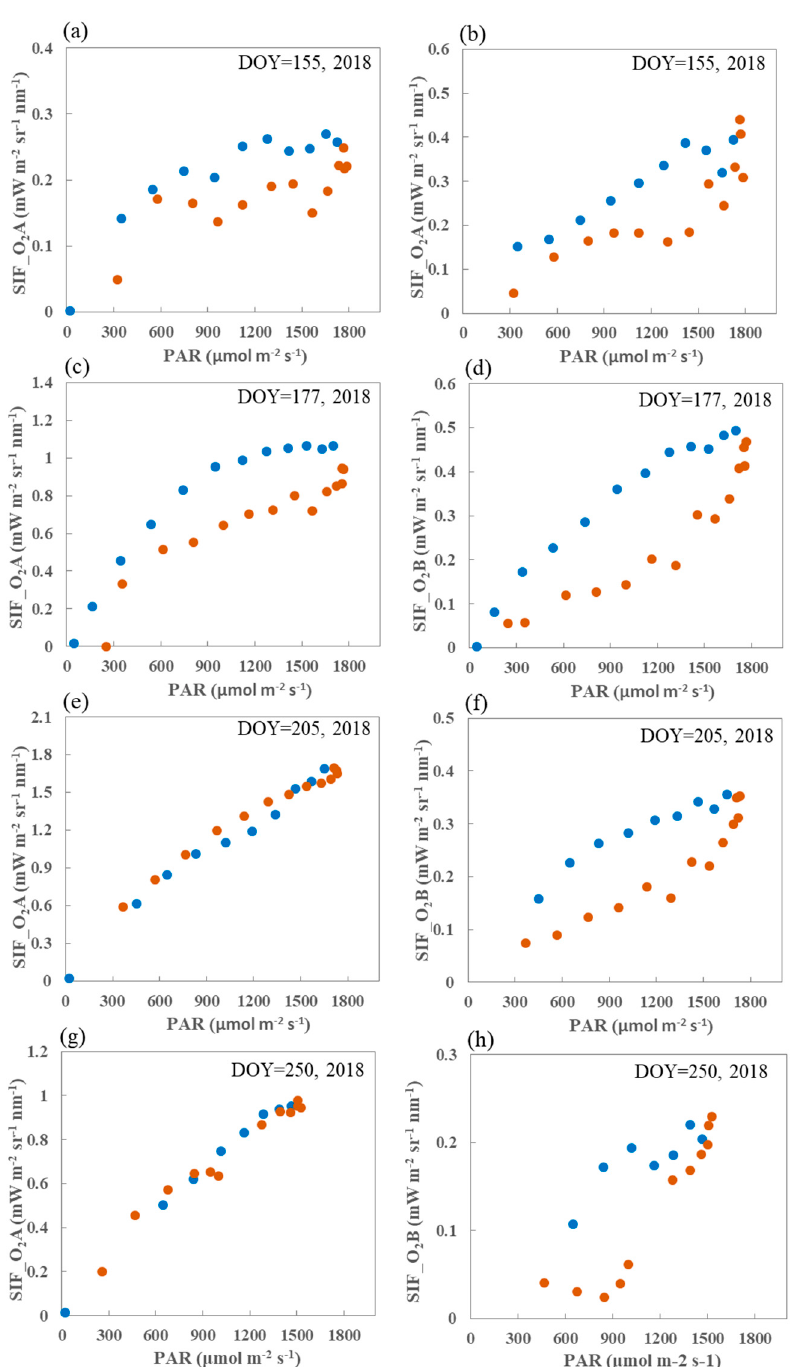
Figure 10. The diurnal response of SIF to PAR at both O 2 –A (left) and O 2 –B (right) bands at the DM site on four different days during the 2018 growing season. The blue and orange points indicate morning and afternoon,